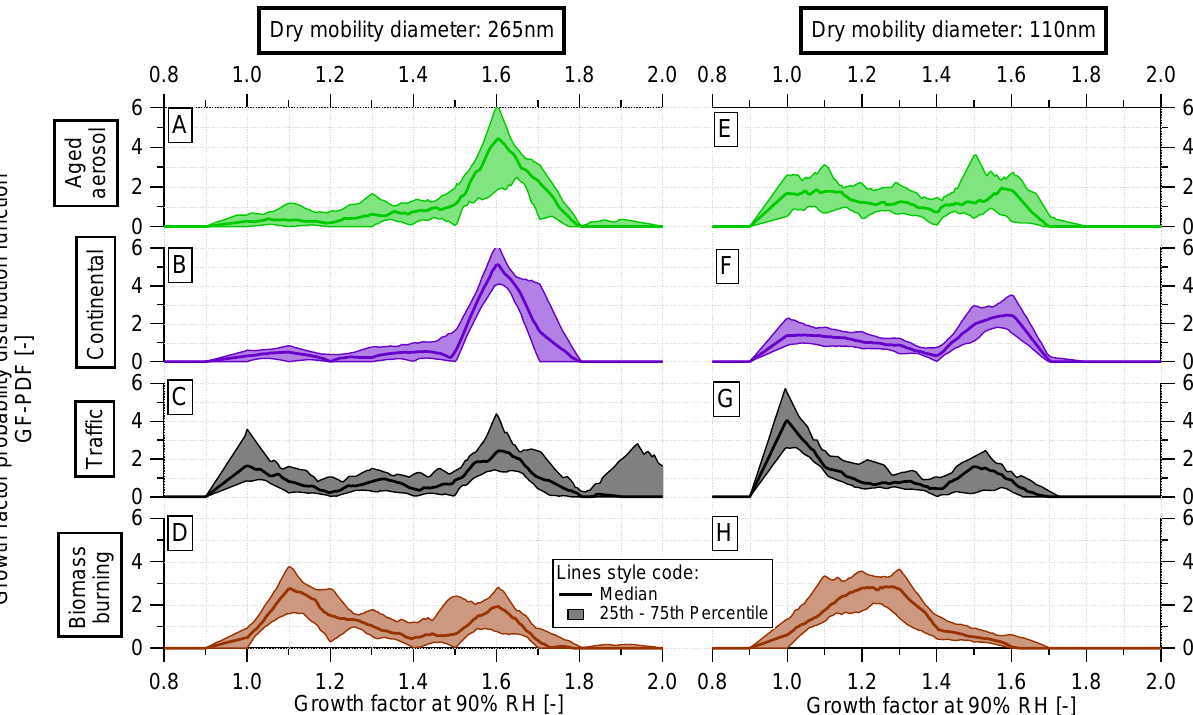
Fig. 13. Median (thicker lines) as well as 25 th and 75 th percentiles (thin lines and shading) of GF-PDF at RH=90%, for each air mass type/aerosol source and for two dry particle mobility diameters: 265nm (left panels) and 110nm (right